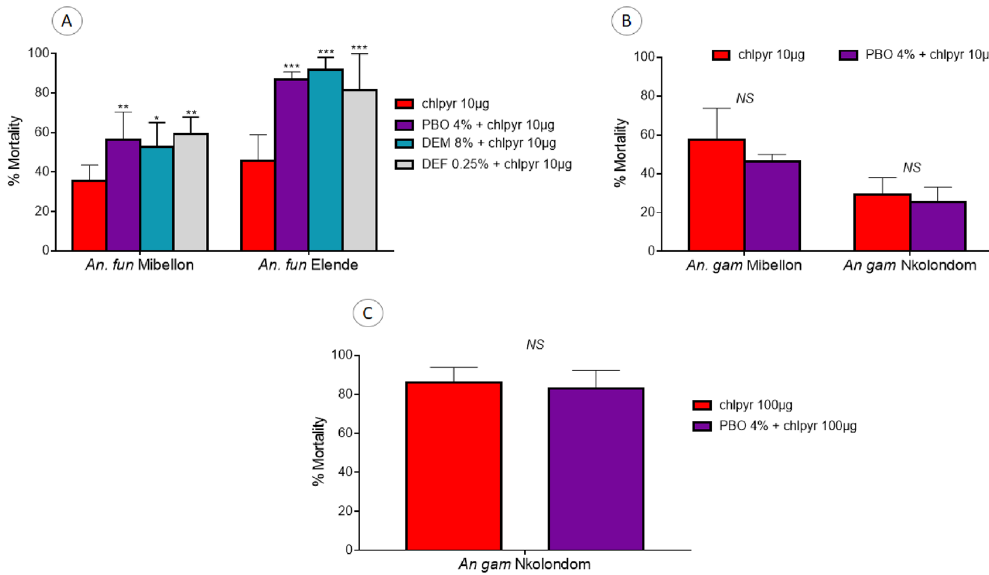
Figure 5. Results of tests with PBO, DEM and DEF. Effect of pre-exposure to inhibitors PBO, DEM and DEF against chlorfenpayr 10 μg/ml for An. funestus (from Mibellon and Elende) and An. gambiae (from Mibellon and Nkolondom) and 100 μg/ml for An. gambiae from Nkolondom. Results are average of percentage mortalities from four-five replicates each. The bars represent the standard error on the mean (SEM), * indicate the level of significance and NS represents no significant difference.